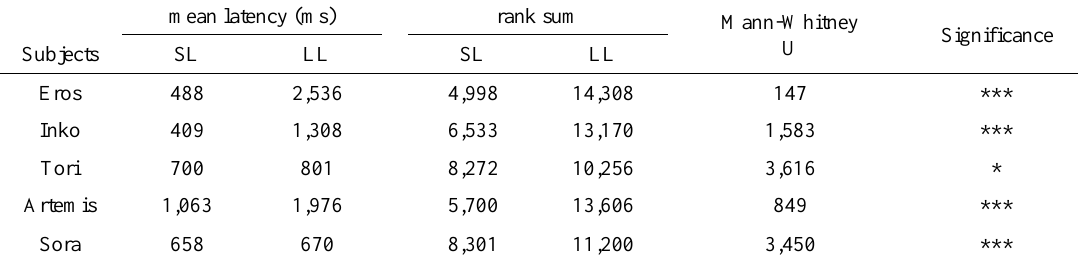
Difference of Response Latency Between Two Playback Sounds